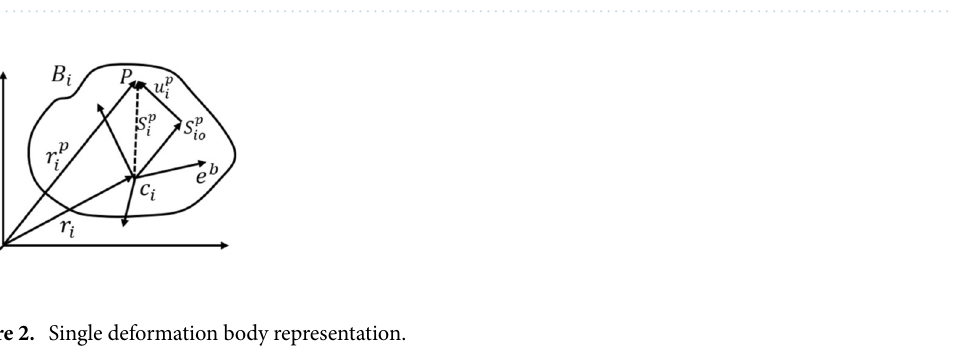
Figure 1. The analysis process of simulation and experiment.